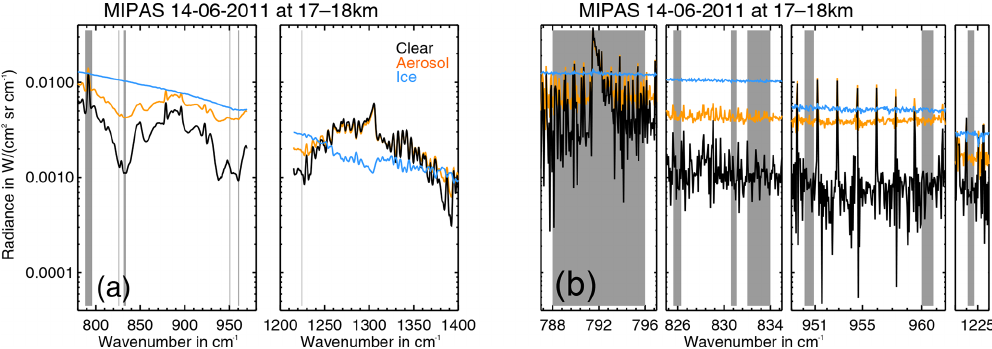
Figure 1. Representative MIPAS spectra for clear air, ice cloud, and aerosol measured on 14 June 2011 between 17 and 18km altitude. (a) MIPAS band A and B spectra smoothed to 1cm − 1 spectral resolution. (b) High-resolution MIPAS spectra only in the window regions used for aerosol or cloud detection and discrimination. The grey background indicates the window regions.